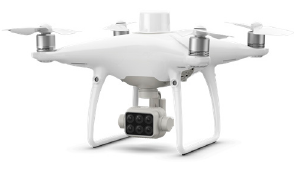
Figure 1. Overview of the study areas. ( a ) The locations of the study areas. ( b1 – b3 ) digital orthophoto maps of Areas A, B, and C acquired by a UAV, respectively.